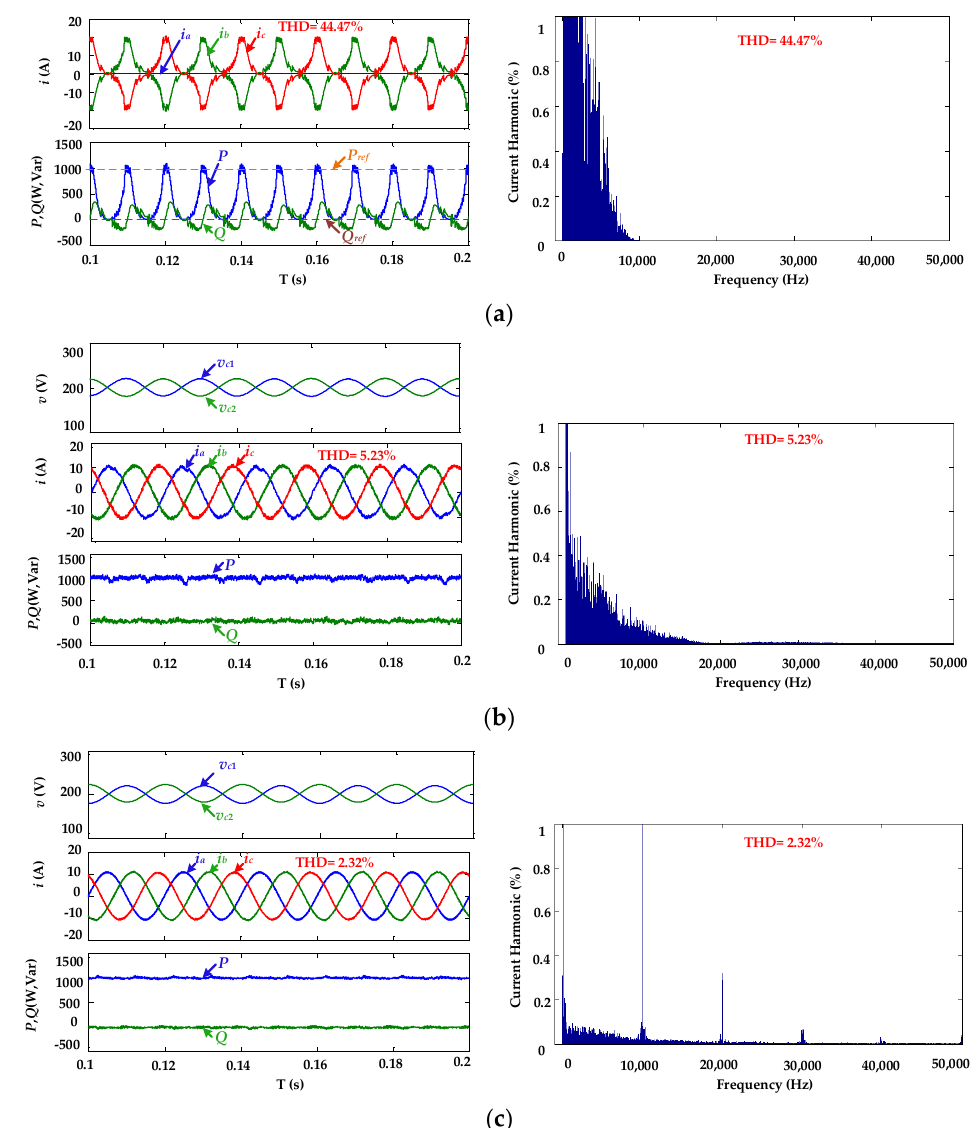
Figure 7. Simulation results with a Phase A fault in inverter mode. ( a ) MPDPC for a three-phase six-switch (TPSS) converter. ( b ) MPDPC for TPFS. ( c ) proposed CF-MPDPC for TPFS.